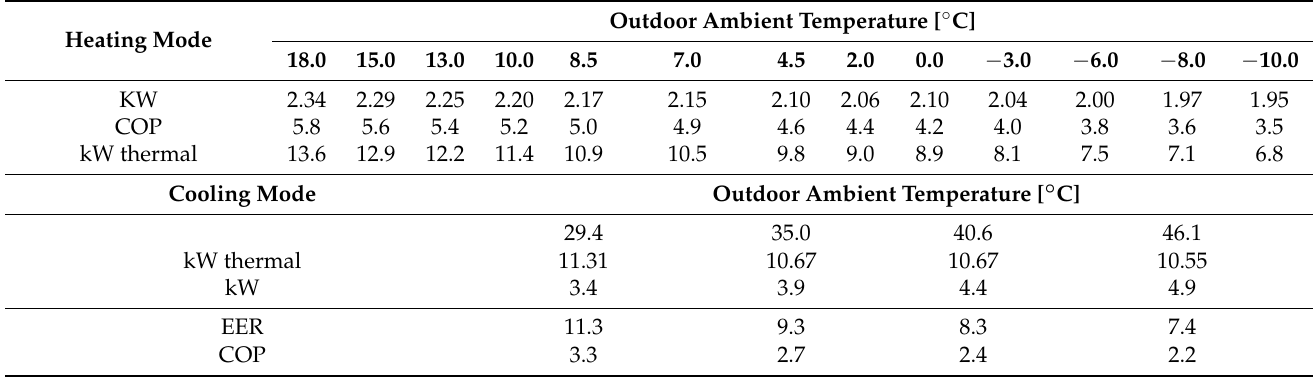
Table A1. Heating and cooling mode characteristics of the air-to-water heat pump.